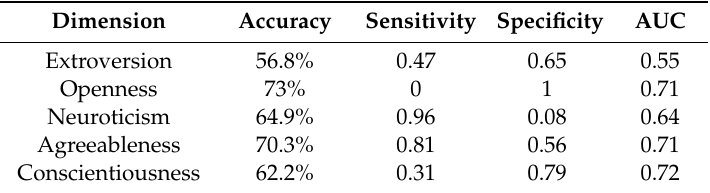
Table 3. Results for low valence high arousal (LVHA) scenario.